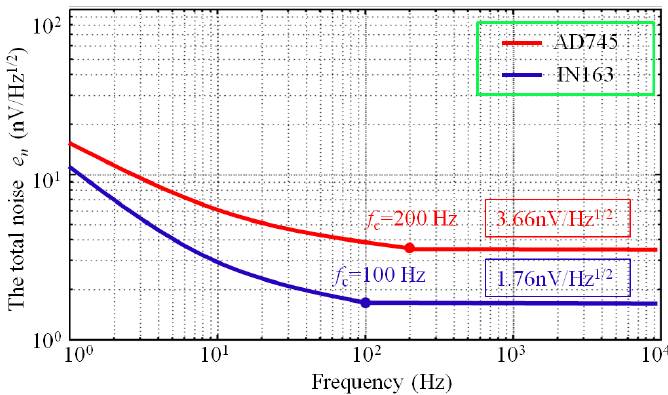
Figure 11. The total noises of two sensors calculated using AD745 and INA163.